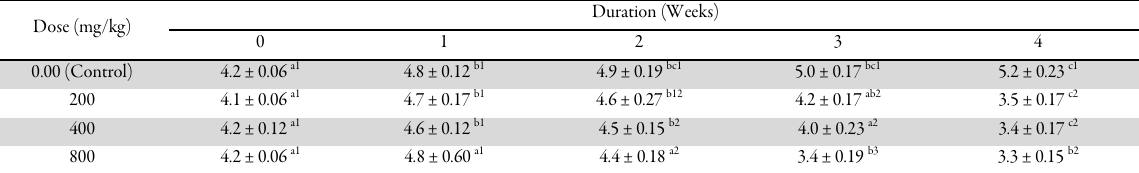
Table 2. Effect of Lipton tea aqueous extract on triglycerides of normal albino rats Dose (mg/kg)